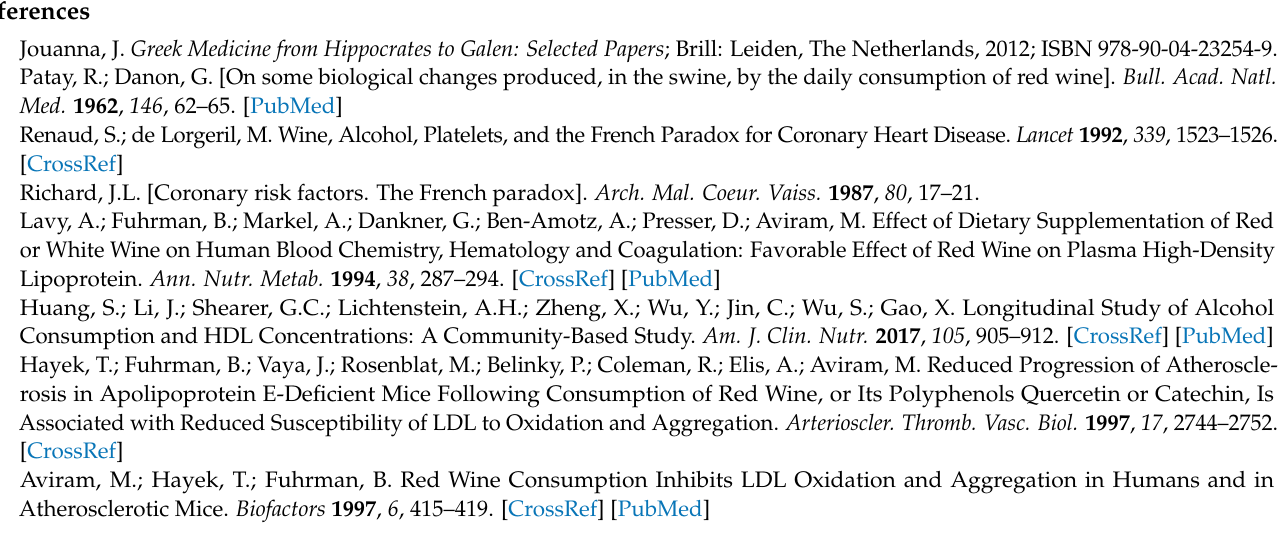
wine consumption. Table S2, Lack of effect of moderate red wine consumption on vitamin E, lipid peroxidation, or biomarkers of inflammation, Table S3, General biochemical and clinical parameters. Table S4, Relative contribution of selected metabolic spectral clusters to overall metabolic